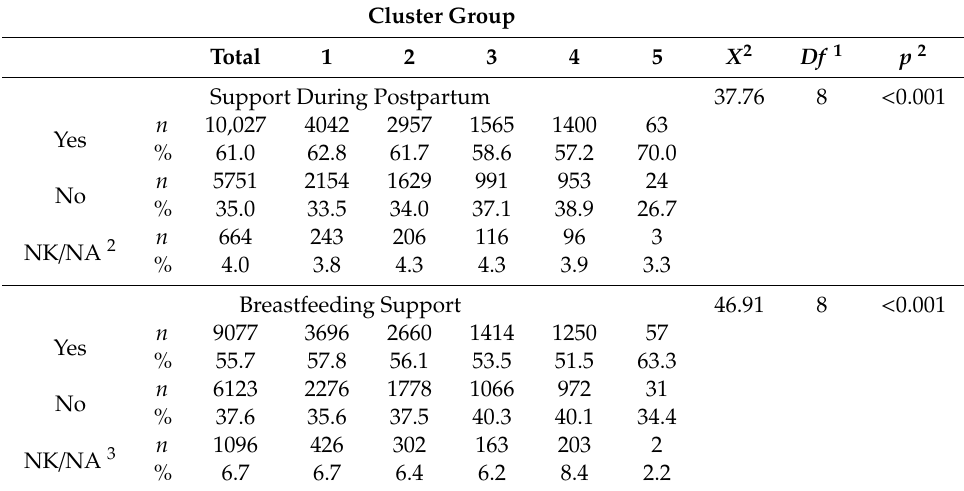
Table 5. The bivariate analysis results of the variables related to the postpartum and